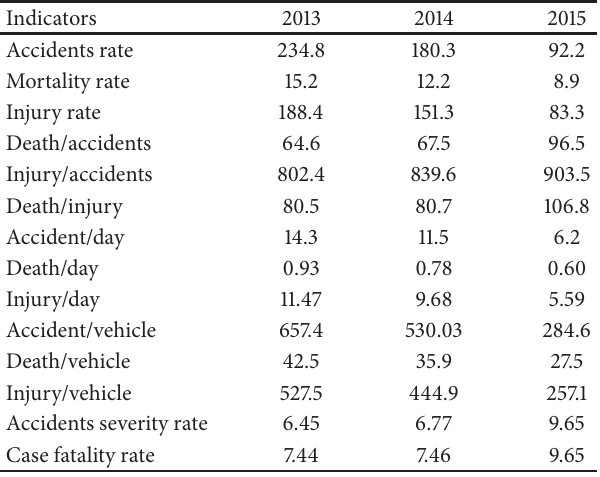
Table 5: Severity indicators of road traffic